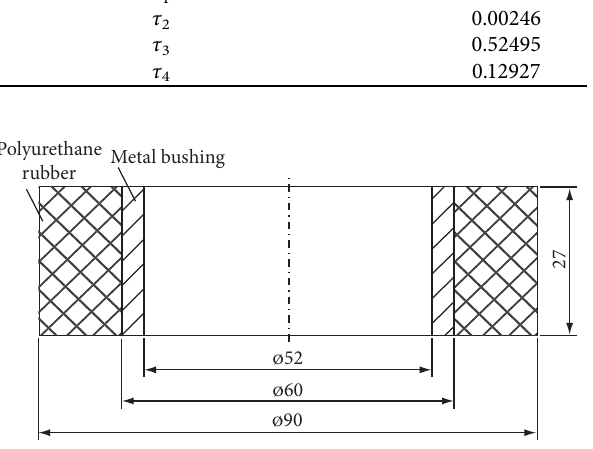
Figure 9: Structural drawing of the shaft damping ring.